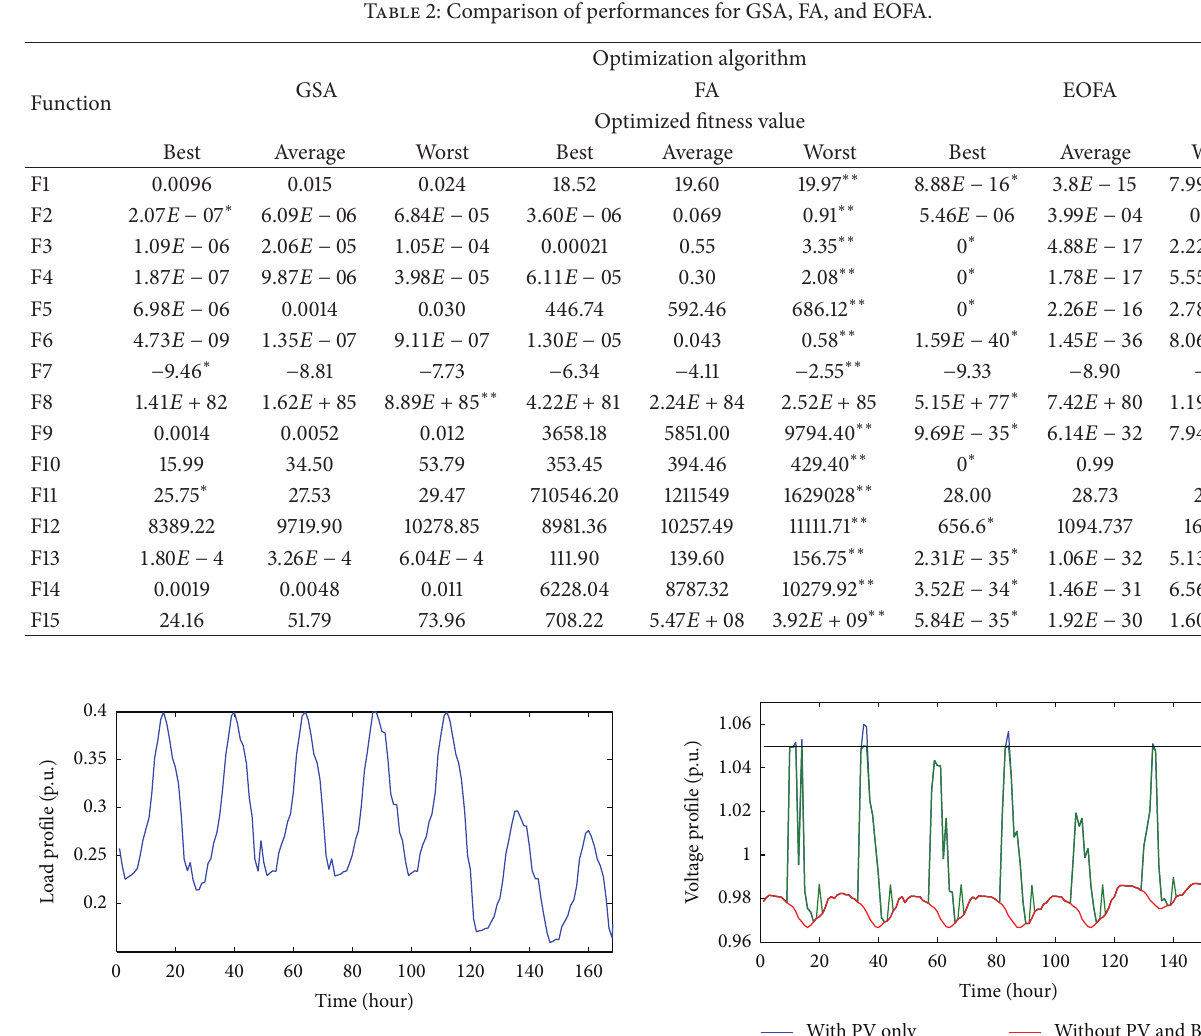
Figure 6: Hourly individual load profile for one week.